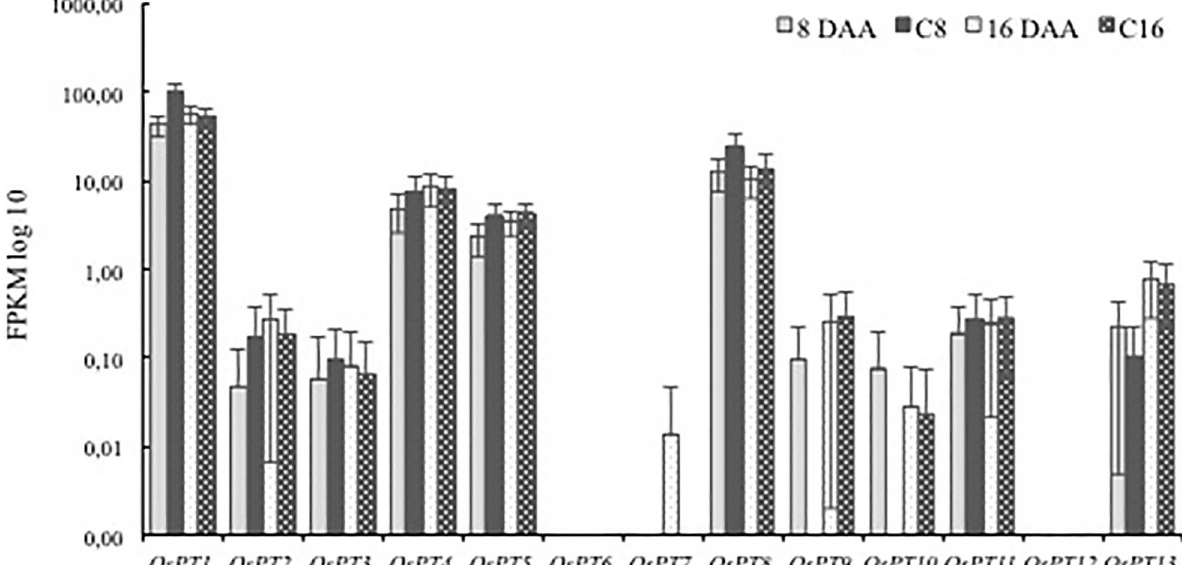
Fig 4. The expression of the PHT 1 family of rice P transporters in rice flag leaves during grain filling. P values (cid:3)(cid:3)(cid:3) < 0.001, no marks = non- significant.